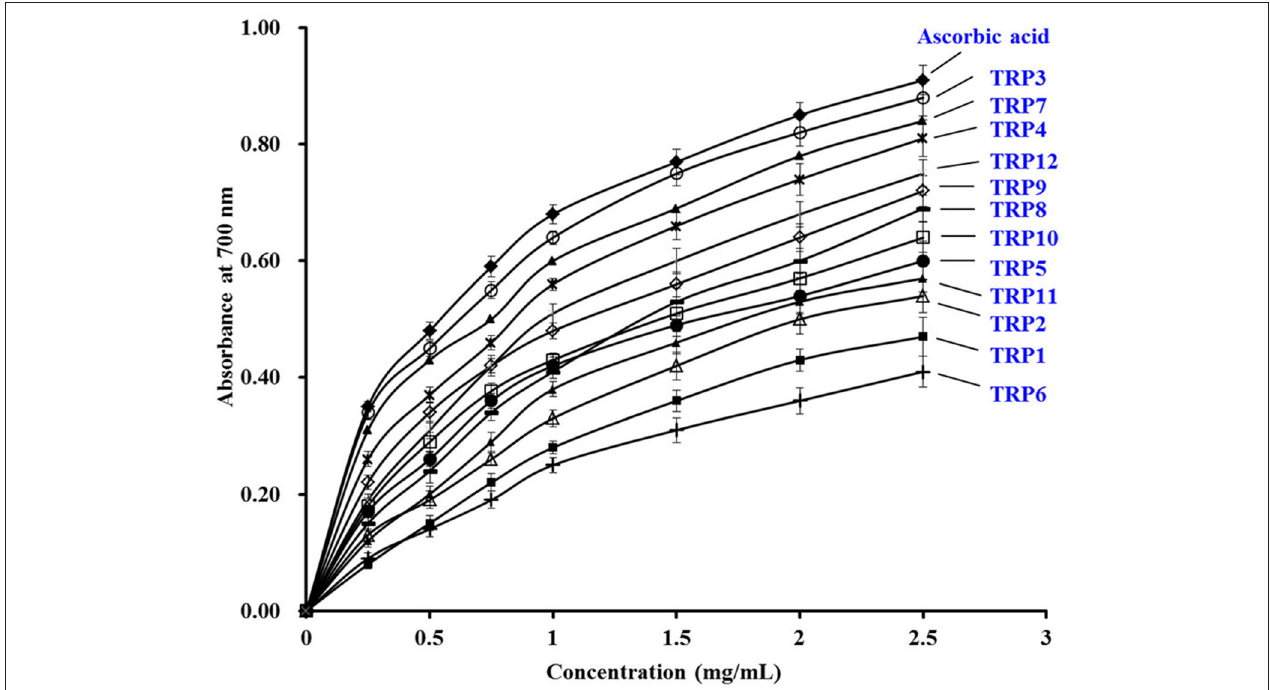
FIGURE 6 | The Ferric-reducing power assays of 12 isolated APs (TRP1 to TRP12) from TRPH. The data are presented as the mean ± SD ( n = 3).